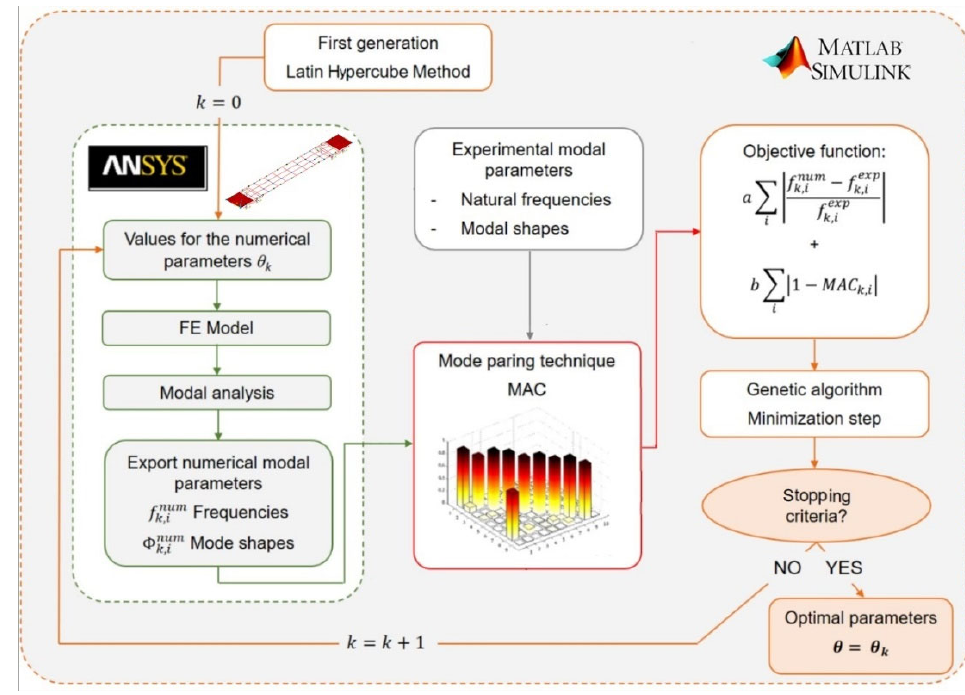
Figure 13. Model calibration